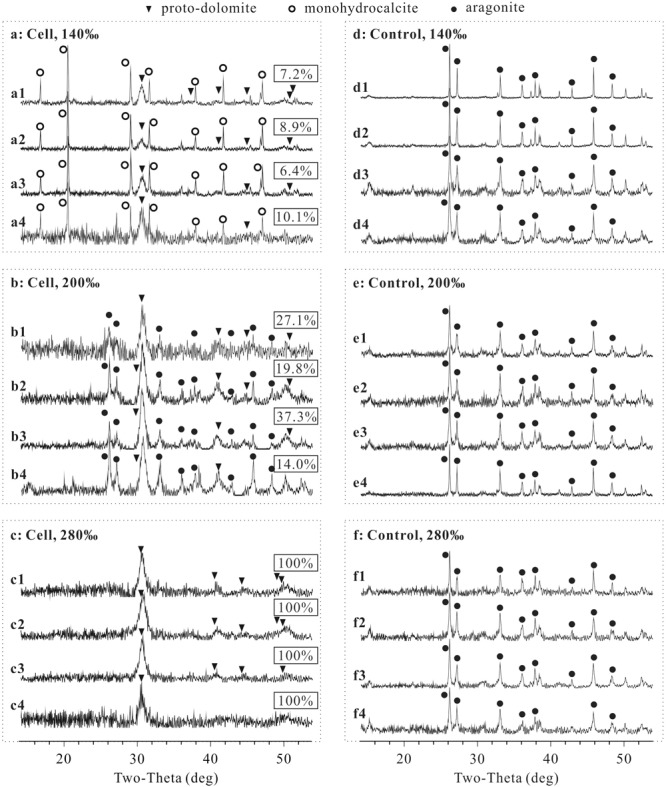
X-ray diffraction (XRD) spectra of precipitates and the percentages of proto-dolomite therein mediated by N. sp. J7-1 in media with various sulfate concentrations and salinities. The concentrations of sulfate in “X1,” “X2,” “X3,” and “X4” are 0, 3, 29.8, and 100 mM, respectively, “X” = a, b, c, d, e, or f. Only partial XRD spectra (2𝜃 = 14 to 54°) are presented here, as all peaks are located within this zone. The rectangular labels show the percentages of proto-dolomite in each precipitate. (a) is the group with cells mineralized in solution with a salinity of 140‰, (b) is the group with cells mineralized in solution with a salinity of 200‰, (c) is the group with cells mineralized in solution with a salinity of 280‰, (d) is the group without cells mineralized in solution with a salinity of 140‰, (e) is the group without cells mineralized in solution with salinity of 200‰, and (f) is the group without cells mineralized in solution with a salinity of 280‰.